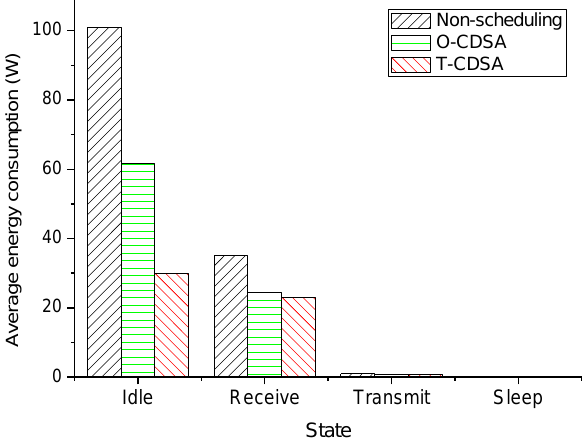
Figure 10. Energy consumption in each